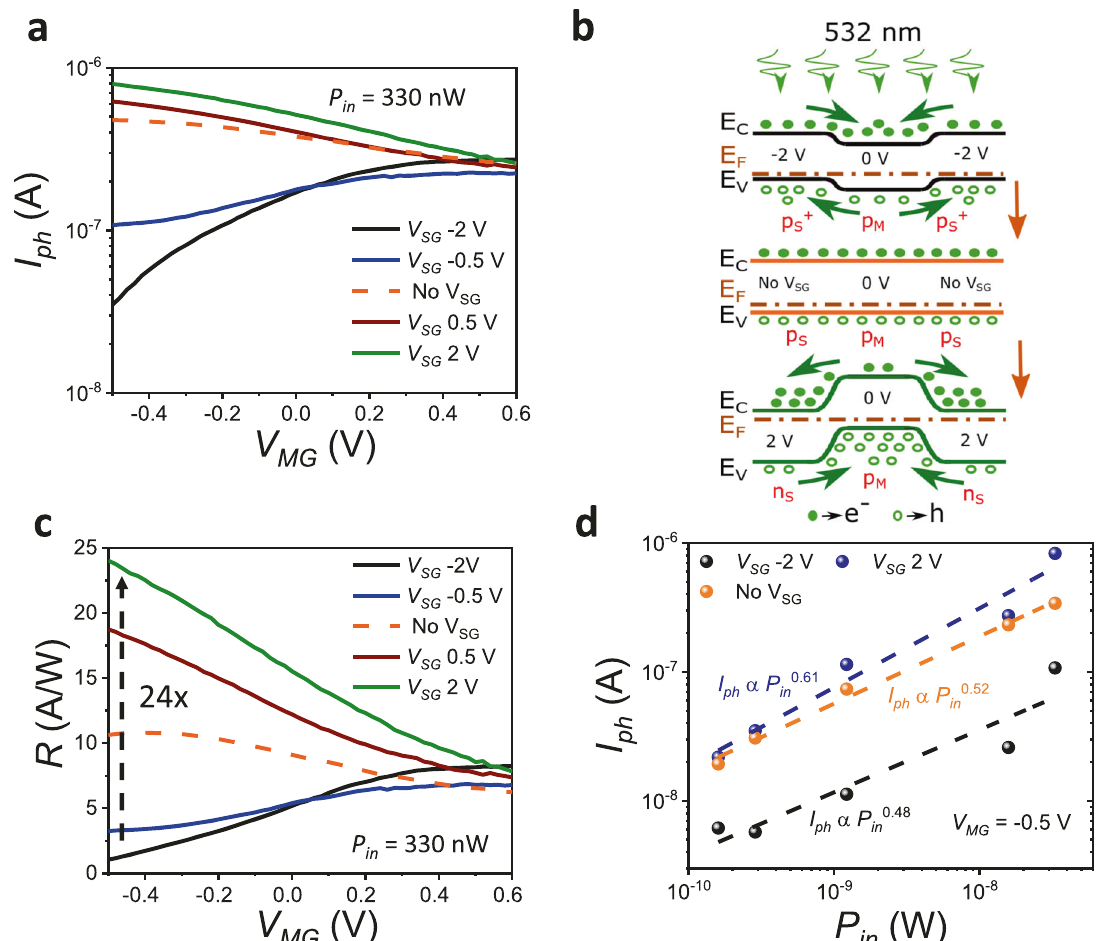
Fig. 3 Device characterization and carrier dynamics under illumination. a I ph under light (532 nm laser) vs V MG , with V SG changing from − 2 to 2 V. An increase in I ph is observed due to charge separation at the lateral p – n junction leading to an in fl ow of holes into the MG channel. b Band diagrams across SG-MG-SG showing ef fi cient (holes towards the channel and electrons towards the SG regions) photogenerated e-h separation at the diode